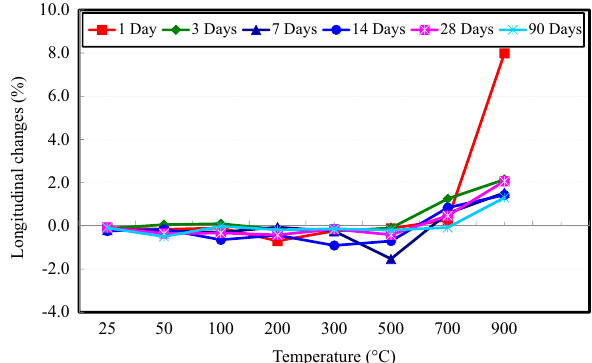
Figure 6: Curve of longitudinal changes of concrete by temperature.